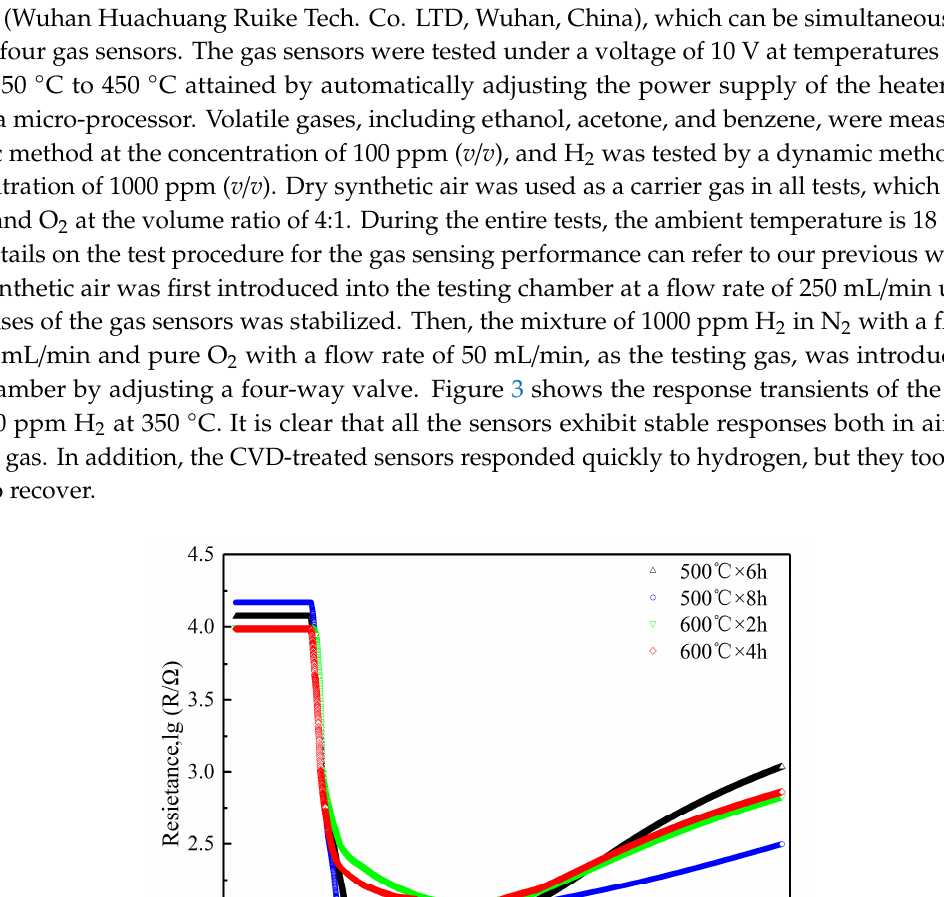
Figure 3. Response transients of the sensors to 1000 ppm H 2 with synthetic air as carrier gas at 350 C.